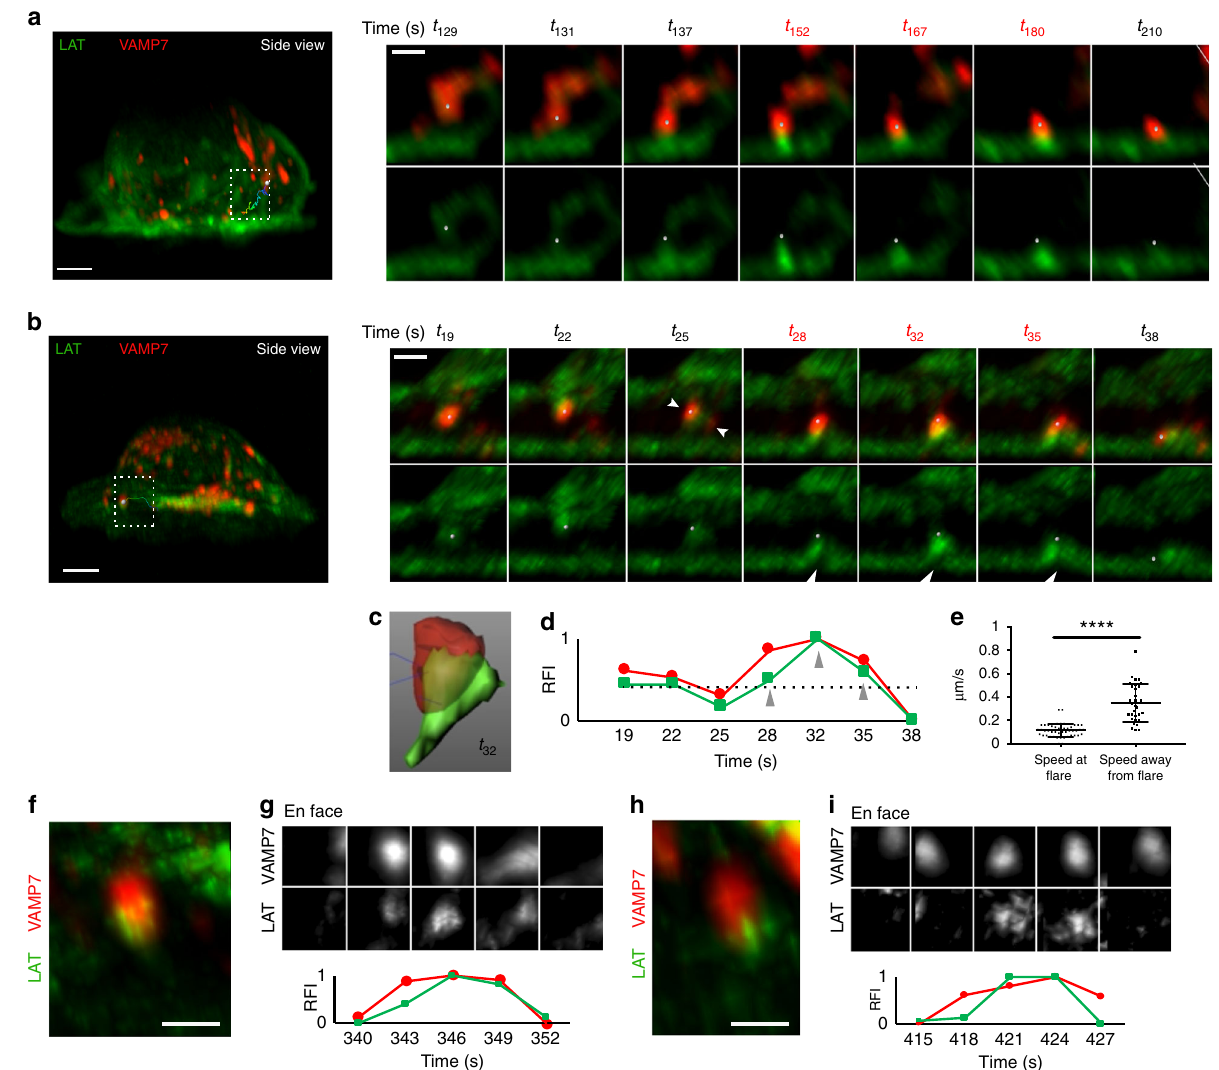
Fig. 6 LAT and VAMP7 dynamics at later times after activation. Lattice light sheet images of Jurkat cells transfected with LAT-neon green and Halo- VAMP7, dropped onto stimulatory coverslips, and imaged 5 min after initial stimulation. a , b The left panel shows the side view of the entire cell. The boxed region highlights a vesicle track. The tracked vesicle is a gray sphere. The entire track is shown and color-coded to indicate time, with the earliest time point in blue and the latest time point in red. Right panels show zoomed-in views of the vesicle. The top panel shows LAT (green) and VAMP7 (red), while the bottom panel shows LAT only. a A VAMP7 vesicle moving from the inside of the cell to the stimulated surface is shown and in b a VAMP7 vesicle moving from the center of the cell to the periphery is shown. In b white indented arrowheads in t 25 top panel indicate two VAMP7 vesicles that fuse. White arrowheads in t 28 , t 32 , and t 35 indicate the plasma membrane lifting up. Scale bars for a and b left panels equal 2 μ m and right panels equal 0.5 μ m. c Segmented VAMP7 (red) and LAT (green) at a fl are event corresponding to t 32 in b . d Relative fl uorescence intensity (RFI) plots of VAMP7 (red) and LAT (green) intensity sums within the segmented VAMP7 vesicle shown in c over time. Gray arrowheads indicate the times that show the “ fl are ” event. e Speed of VAMP7 vesicles away from and at the site of a fl are were graphed. f , h Zoomed-in views of VAMP7 vesicles showing an increase in LAT fl uorescence at the vesicle tip as it touches down on the plasma membrane. Scale bars equal 0.5 μ m. g , i Top panels show time series showing LAT and VAMP7 increases in an en face view of the plasma membrane. Lower panels show relative fl uorescence intensity (RFI) plots of VAMP7 (red) and LAT (green) ( n = 5 cells, three independent experiments). See also Supplementary Figure